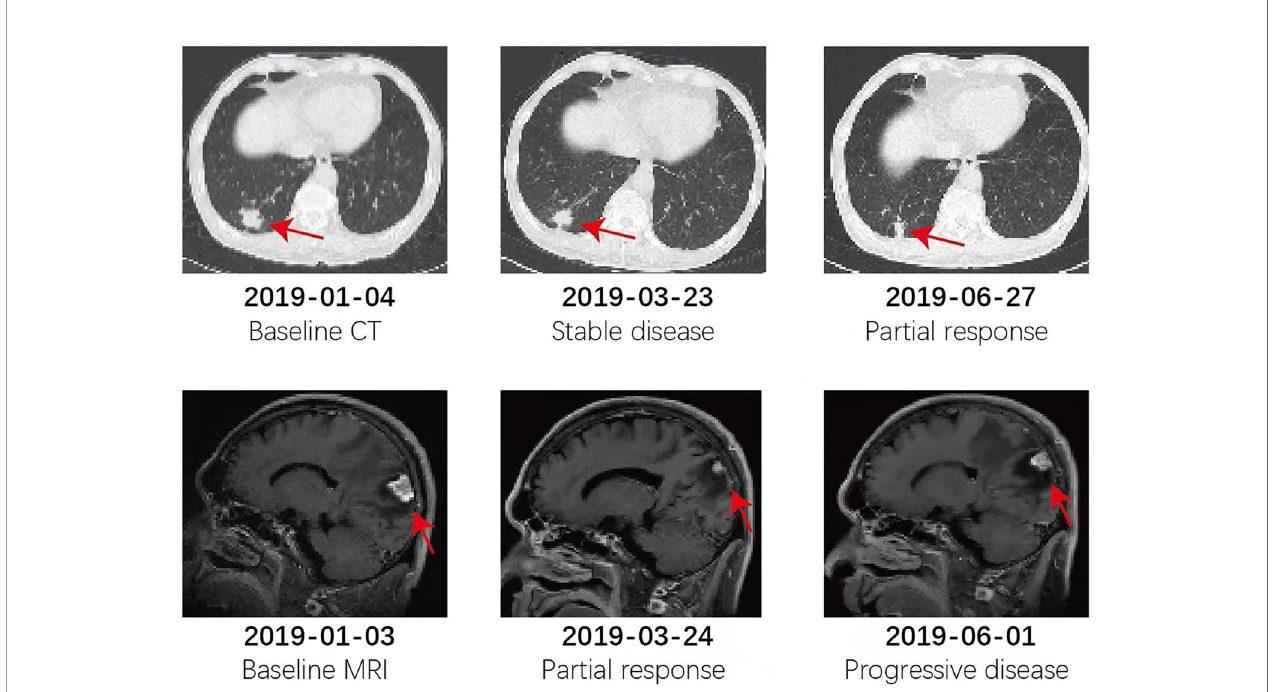
FIGURE 2 | Patient dynamic changes in the chest CT and brain MRI during treatments.